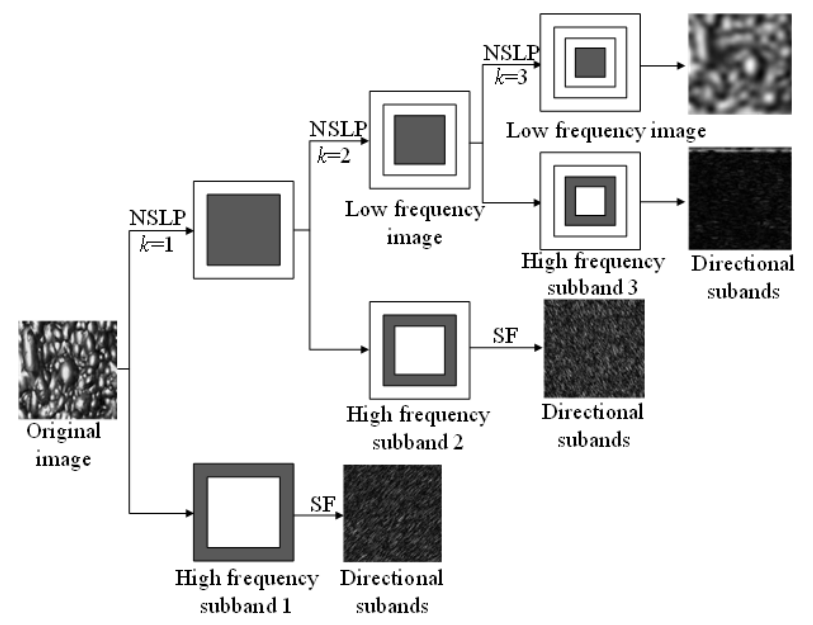
Figure 2. 3-stage NSST multiscale decomposition of bubble image.